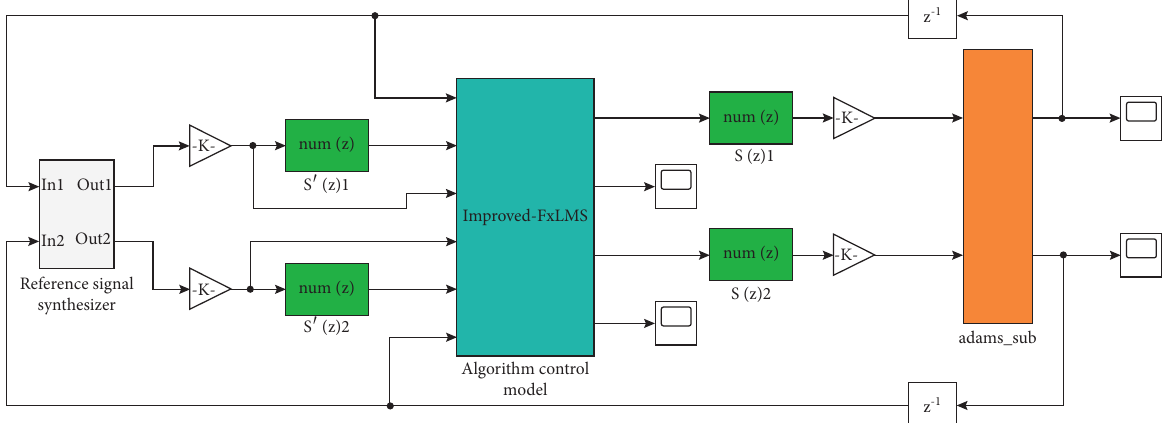
Figure 11: Active vibration control joint simulation system of the